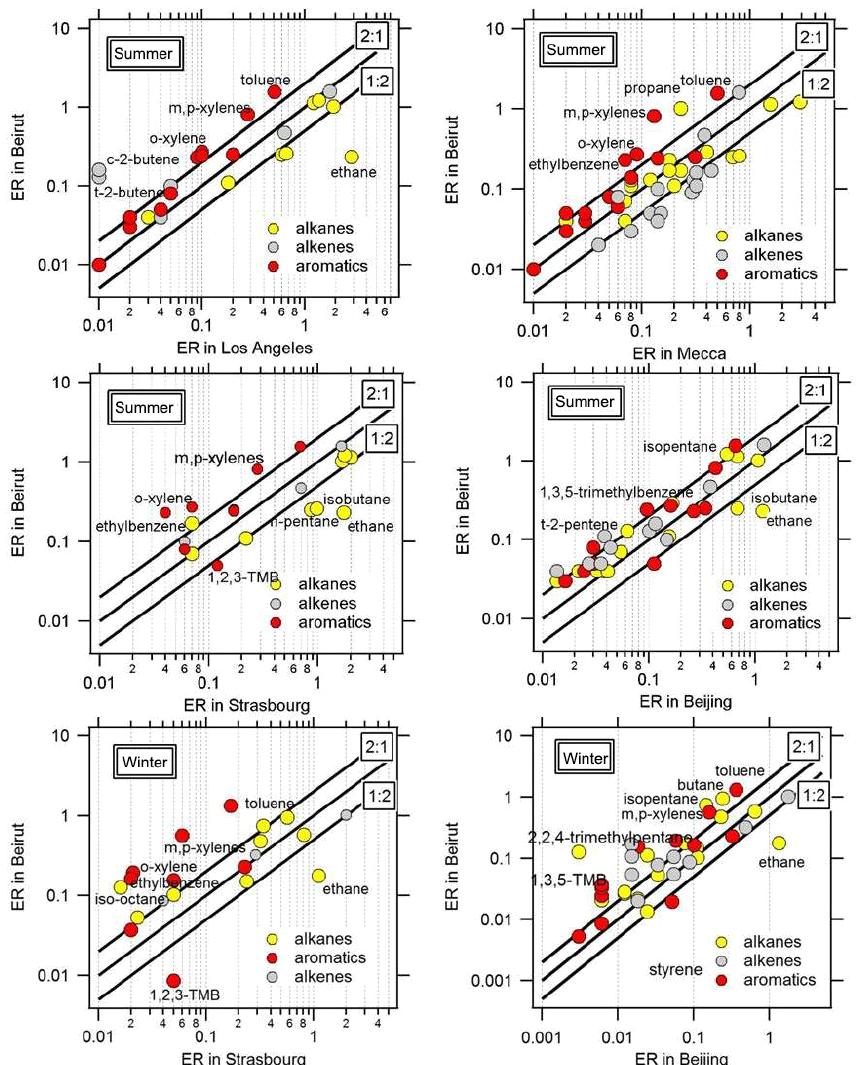
Figure 7. Comparisons of NMVOC emission ratios determined at the Beirut suburban site with those for Los Angeles, US (Borbon et al., 2013); Strasbourg, France (Boynard et al., 2014); Beijing, China (Wang et al., 2014); and Mecca, Saudi Arabia (Simpson et al., 2014) (TMB: